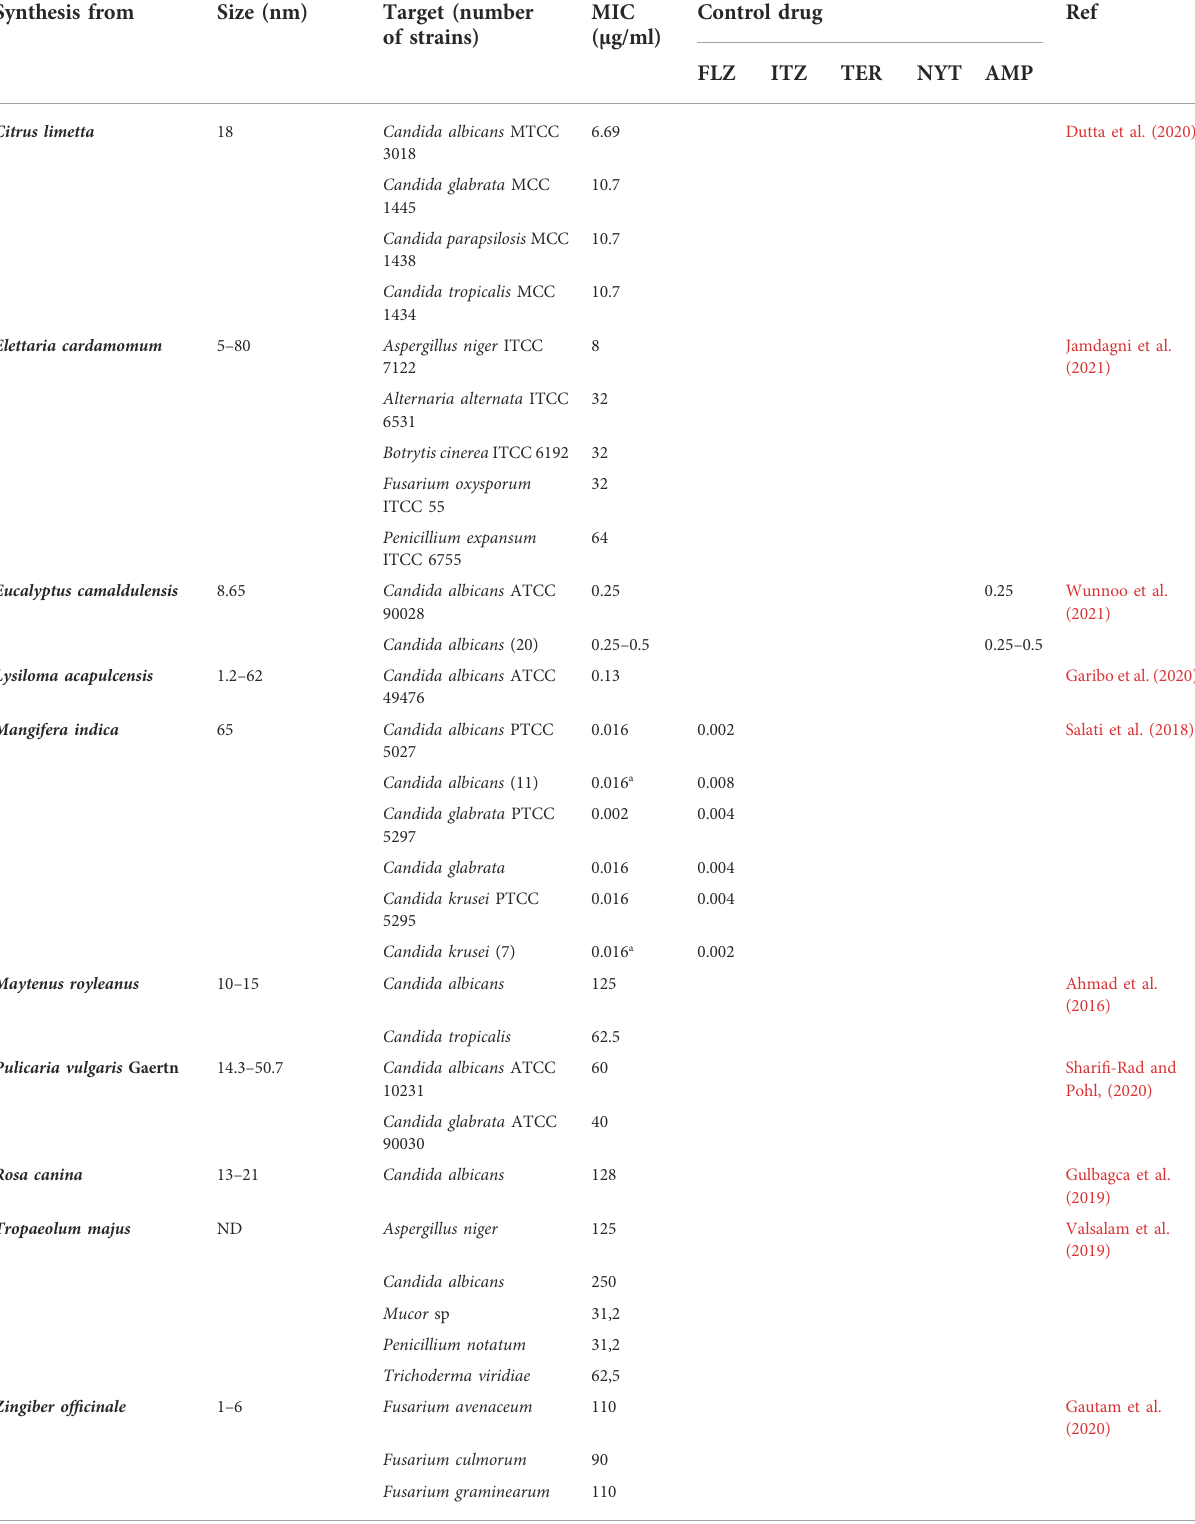
TABLE 1 ( Continued ) Antifungal activity of biogenic